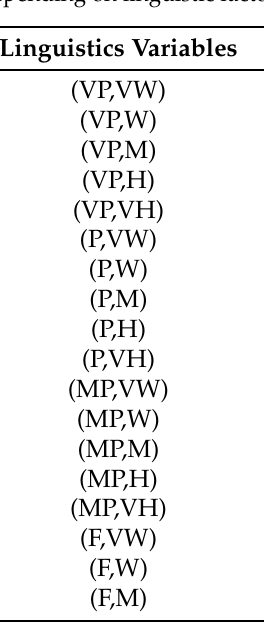
Table 7. For grading failure modes, transformation procedures to convert Z-number to TFN ( ˜ Z ‘ ) depending on linguistic factors are